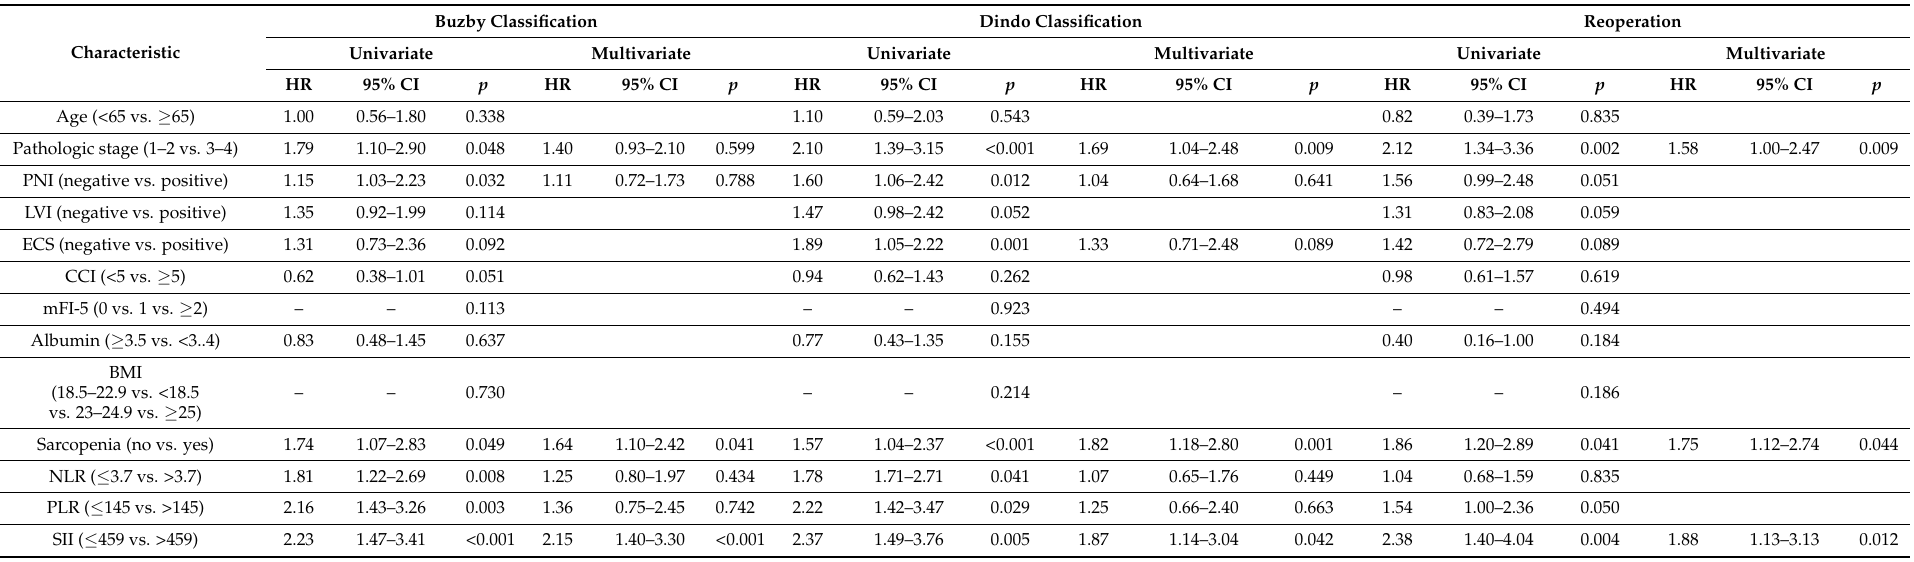
Table 4. Logistic regression analysis between clinical risk factors and surgery-related immediate